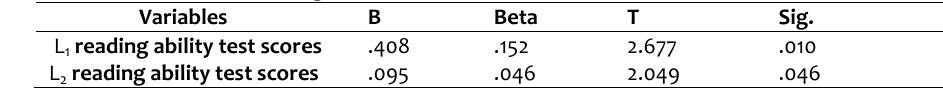
Table 3: Summary of the regression results